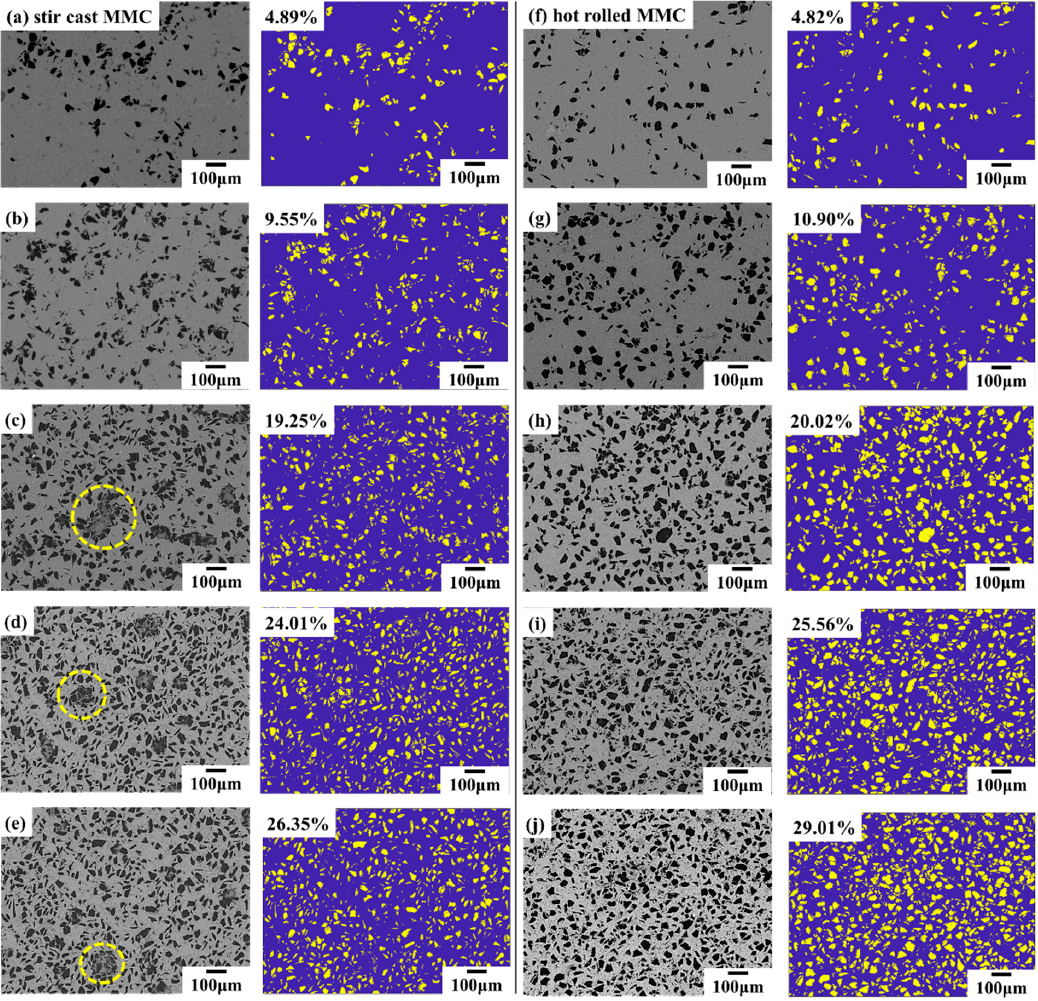
Figure 2. Microstructures of B 4 C/Al6061 stir-cast metal matrix composites (MMCs) with ( a ) 5, ( b ) 10, ( c ) 20, ( d ) 25, and ( e ) 30 vol.% B 4 C and hot-rolled MMCs with ( f ) 5, ( g ) 10, ( h ) 20, ( i ) 25, and ( j ) 30 vol.% B 4 C.